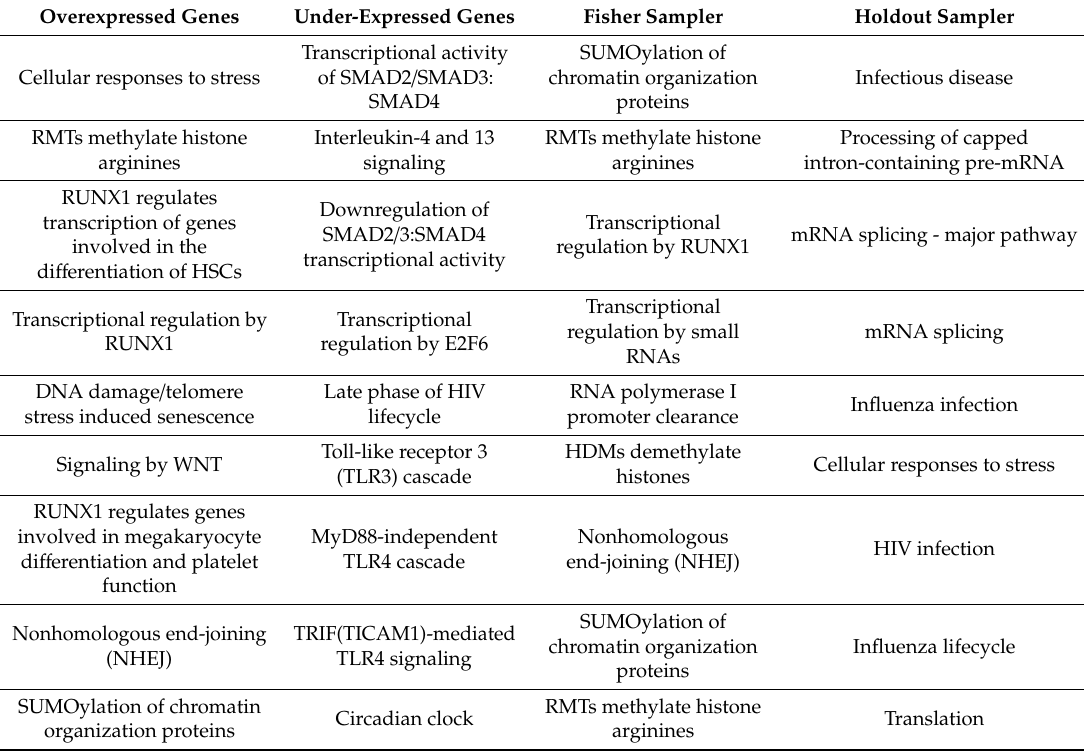
Table 2. GSE24870. Pathway analysis via the Fisher’s ratio and Holdout samplers. Overexpressed